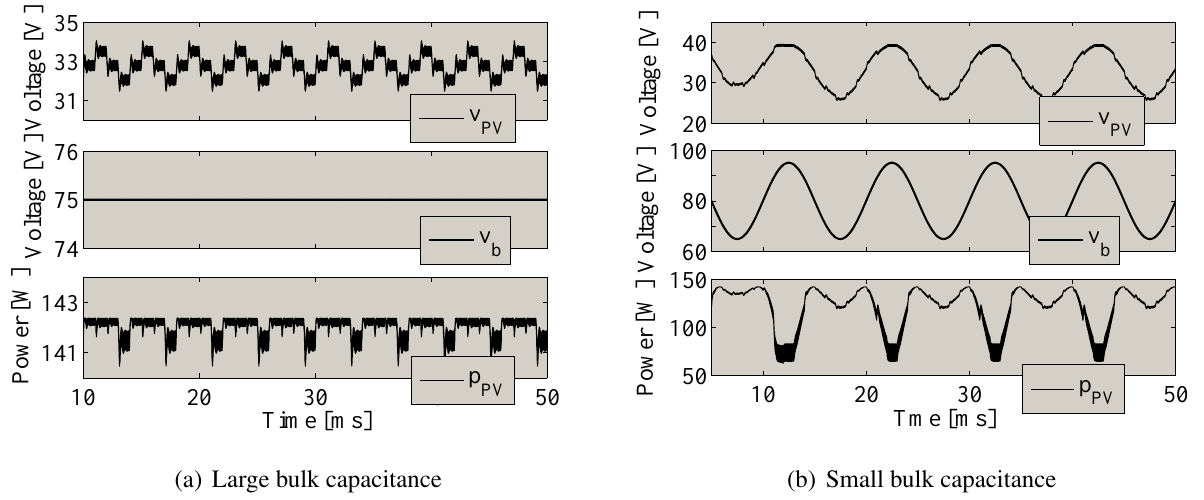
Figure 2. Grid-connected PV system with duty cycle